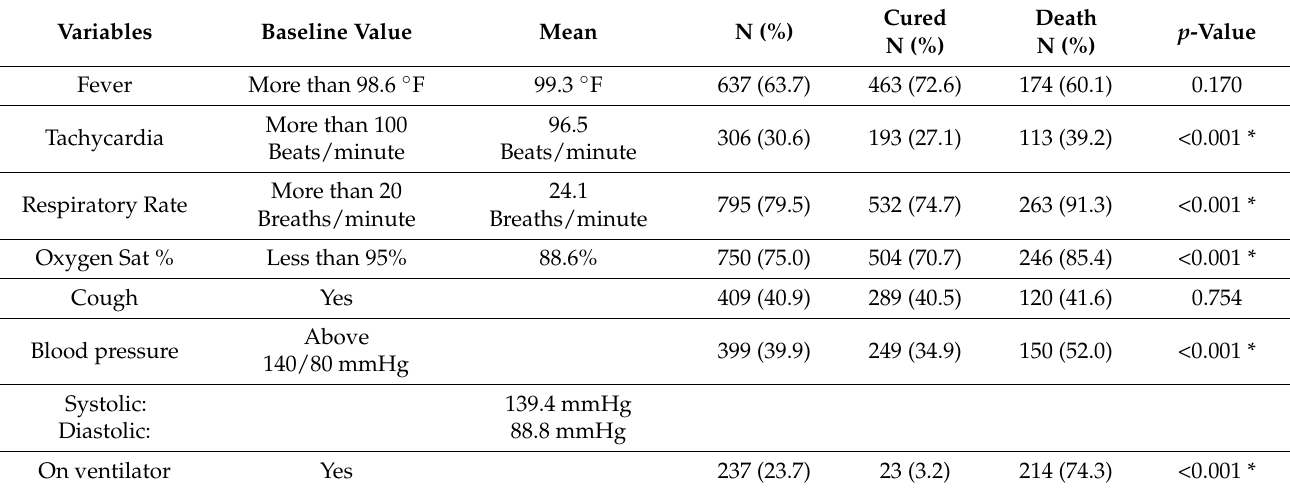
Table 2. Clinical characteristics on initial